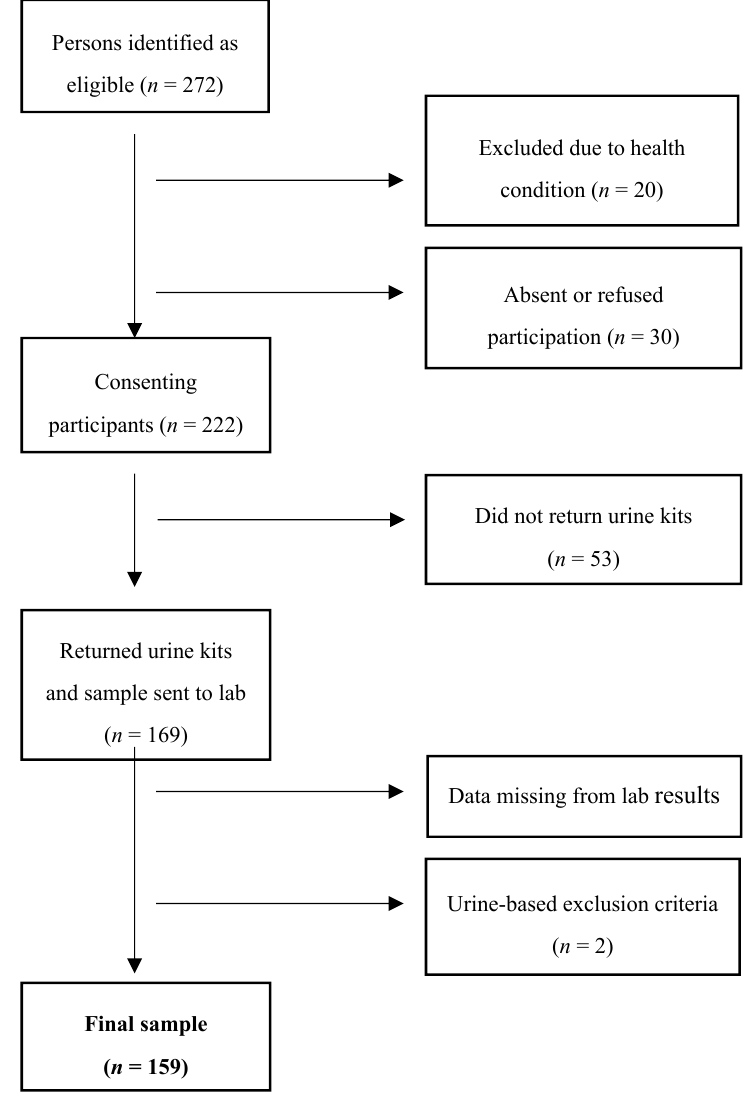
Figure 1. Flow chart illustrating formation of final sample population.